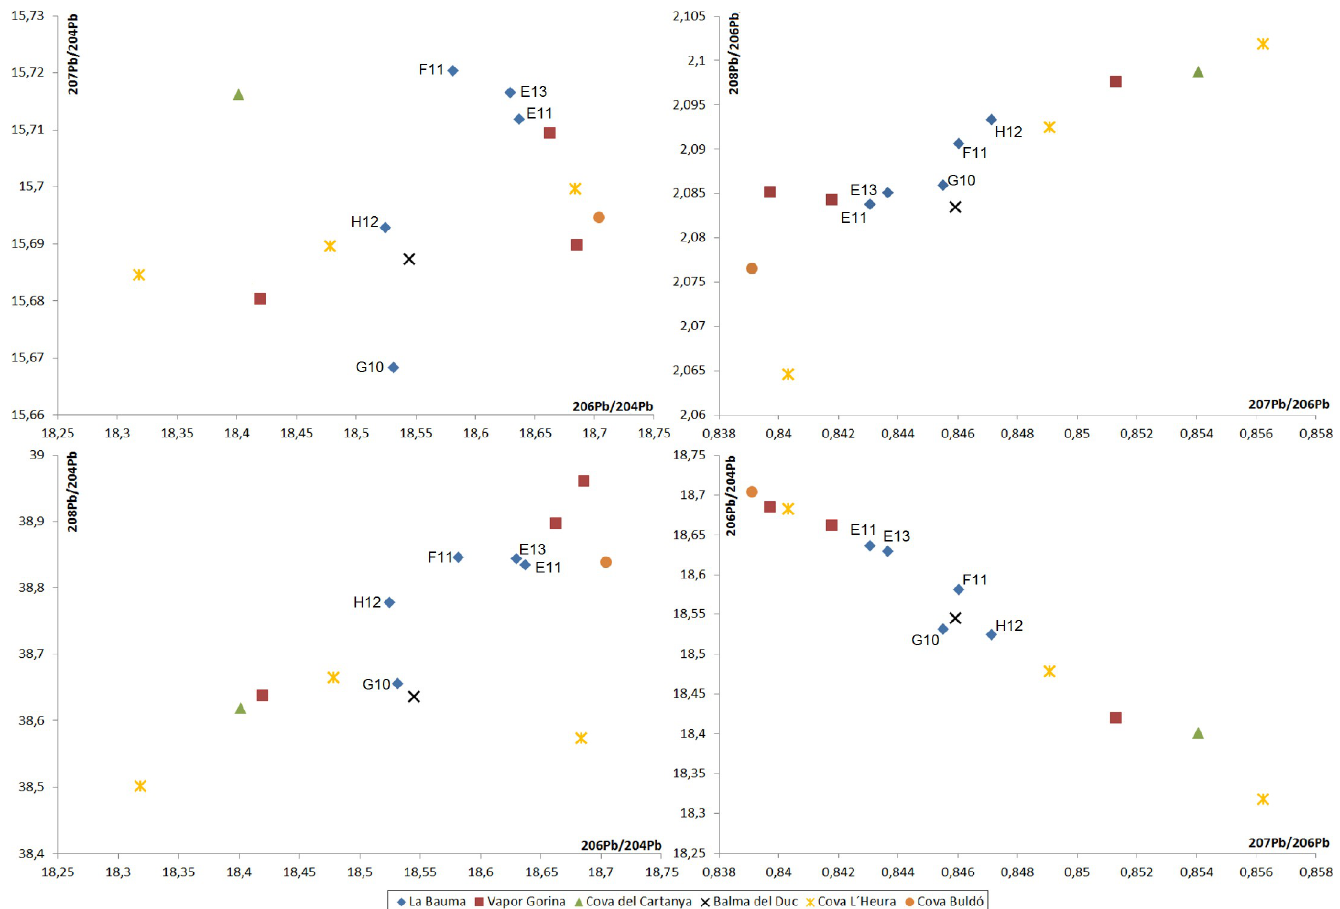
Fig 18. LIA results for La Bauma and other sites located in the